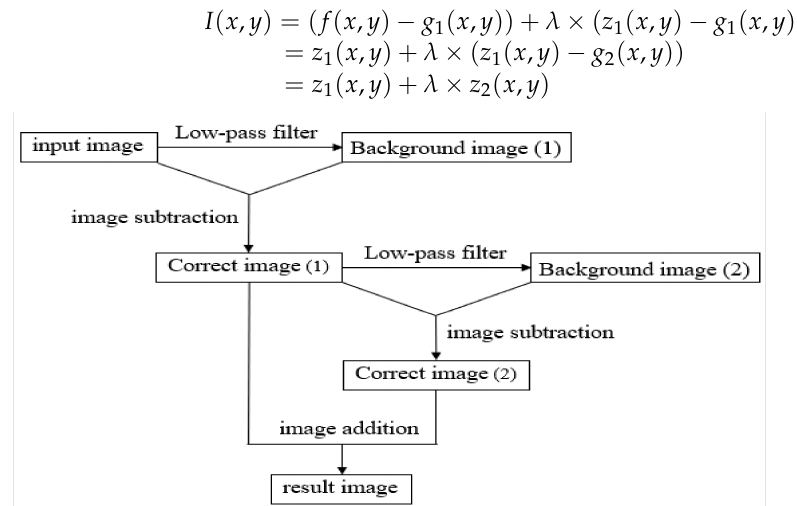
Figure 3. Flowchart of the improved algorithm of mask